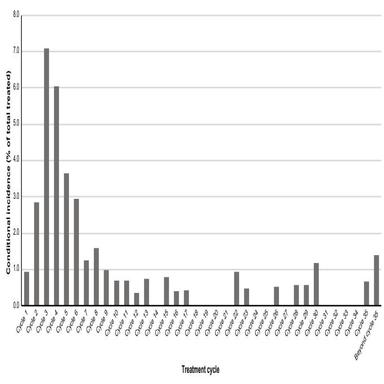
Outcome of all patients with ALT 3T ULN events, by episodes. AE = adverse event; ALT = alanine aminotransferase; HAE = hepatic AE; PD = progressive disease; ULN = upper limit of normal.